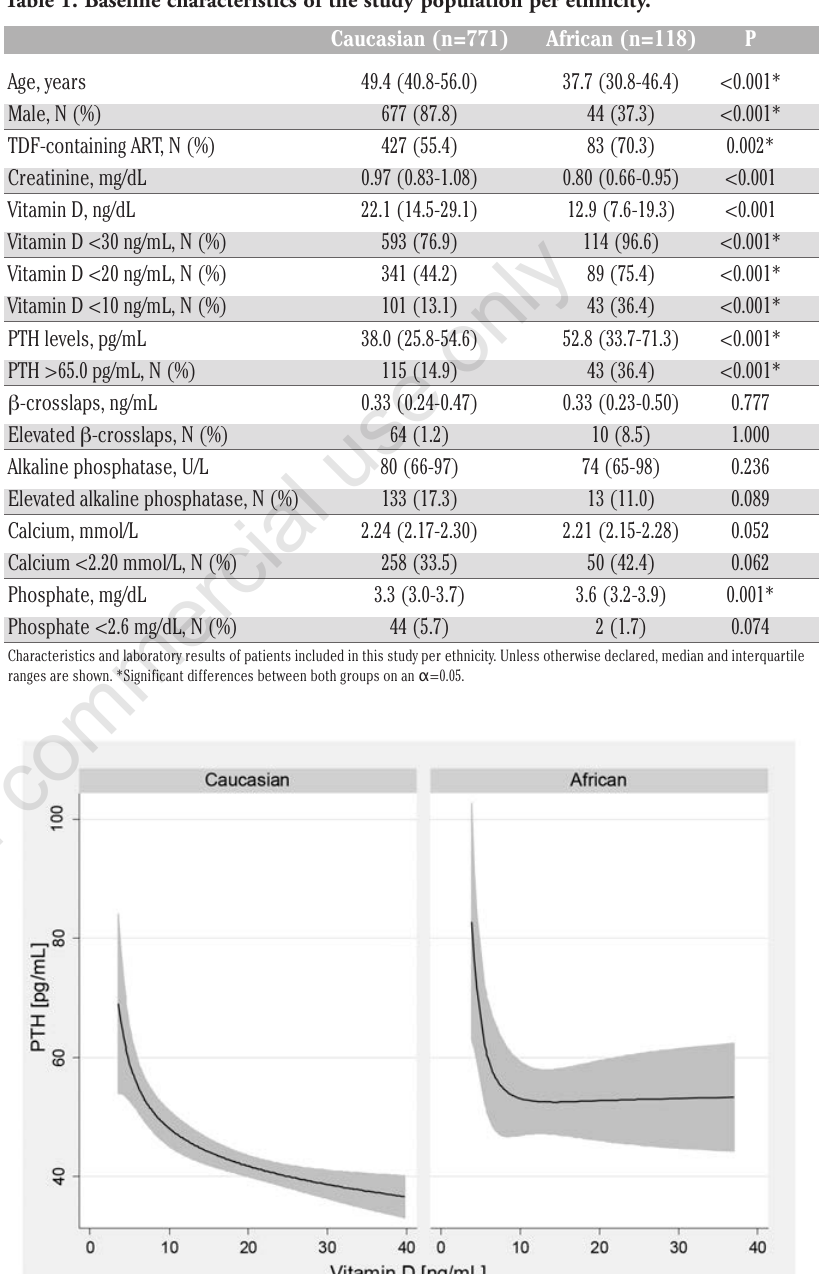
Table 1. Baseline characteristics of the study population per ethnicity.